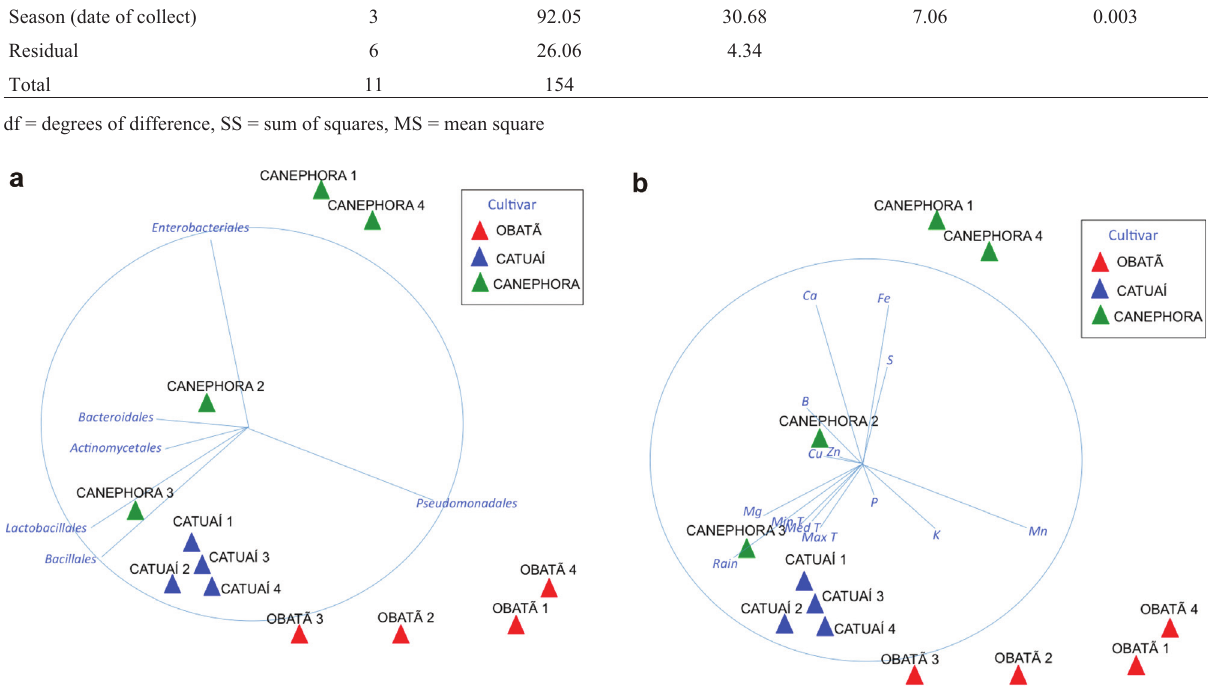
Figure 4 - Two-dimensional non-metric multidimensional scaling (NMDS) plot of bacterial abundance in coffee genotypes, using the Bray-Curtis dis- tance measure. Biological data corresponding to bacterial abundance data (a) and environmental data (b) were overlaid as vectors to improve the visual- ization of correlations. Note the similarity of the direction of vectors ‘Pseudomonadales’ (a) and ‘Mn’ (b).